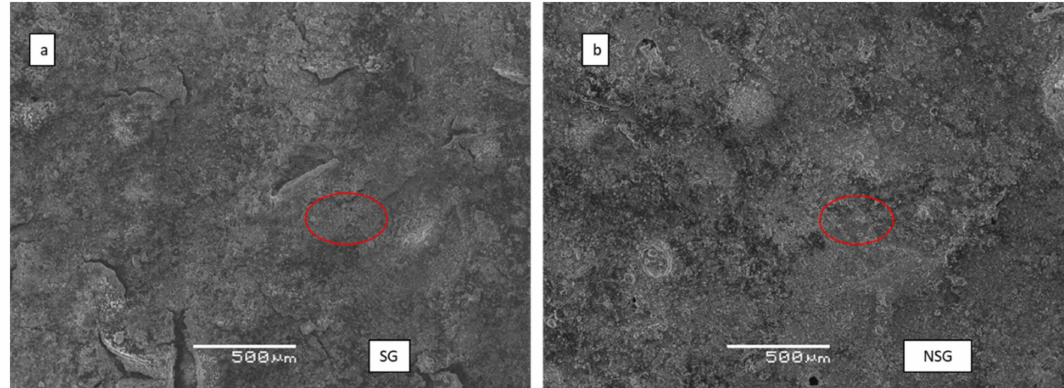
Figure 5. SEM images of SG ( a ) and NSG ( b ) after Karsten tube test. The red circles indicate the point from which the EDS spectra was obtained after the Karsten tube test.